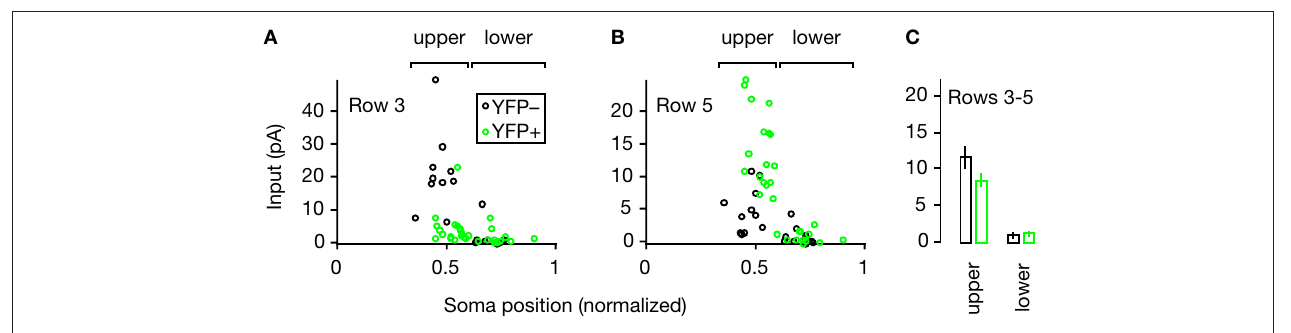
right shows the vertical profi les of the maps in (A) (thick and thin lines represent mean ± s.e.m., respectively), obtained by projecting the array data horizontally (i.e., averaging along rows). Note radially alternating sources of input (black and green arrows) to the two cell types.